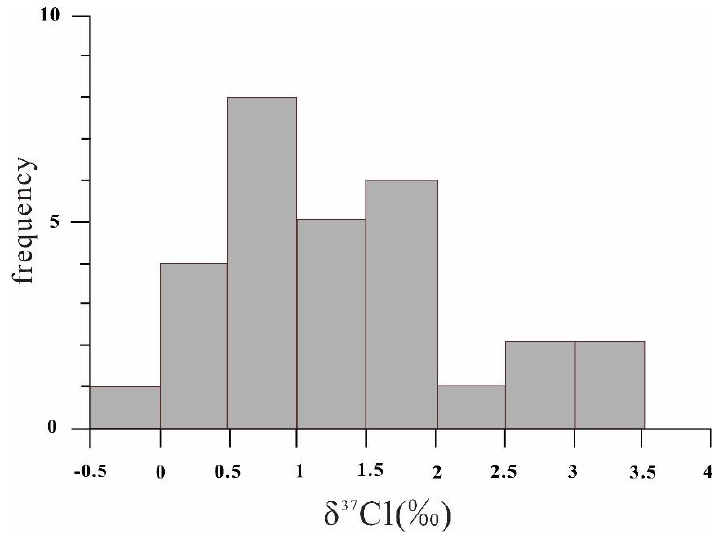
Figure 11. Sample distribution frequency of chlorine isotopic composition in Xishanzui brine.